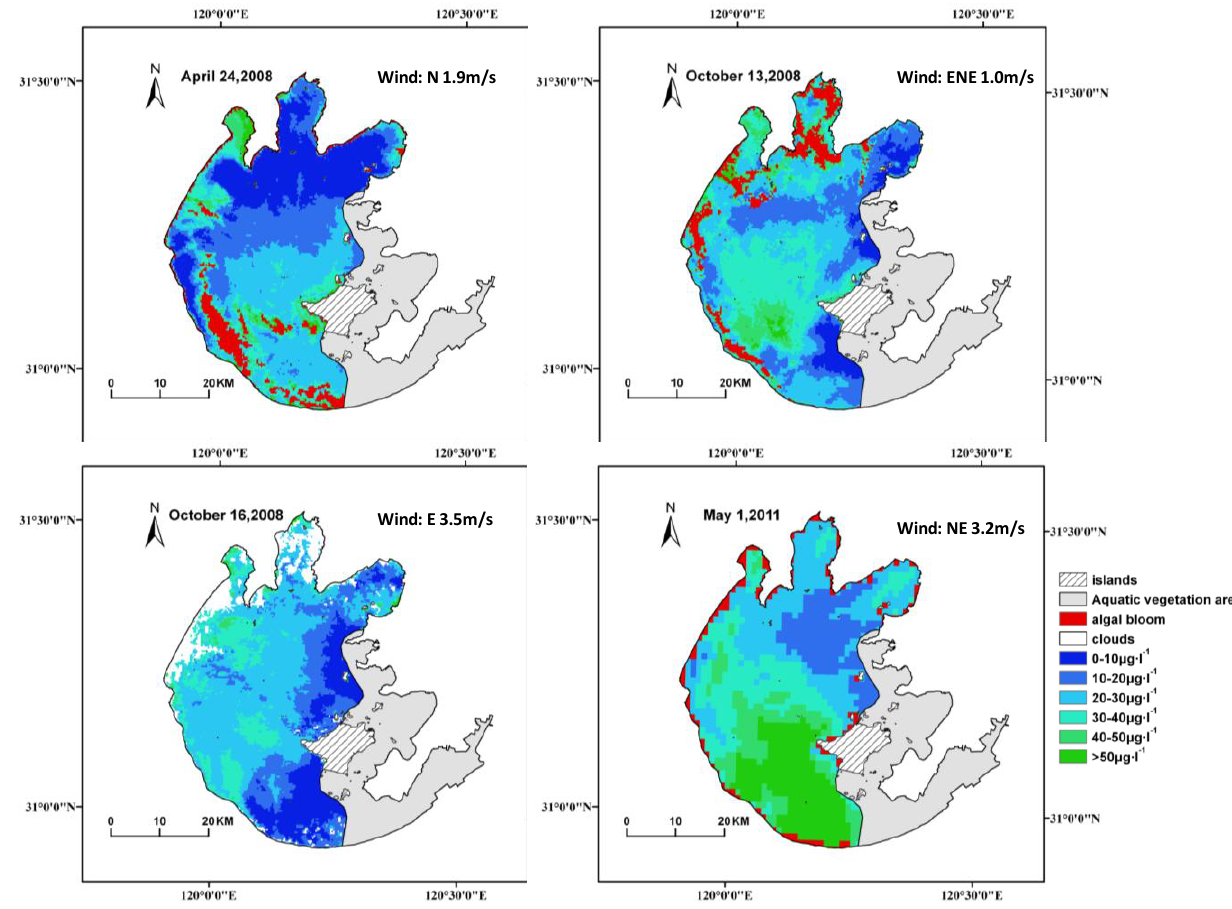
Figure 7. The estimated distribution of Chla using the spectral decomposition model with MERIS images for 24 April, 13 October and 16 October 2008 and 1 May